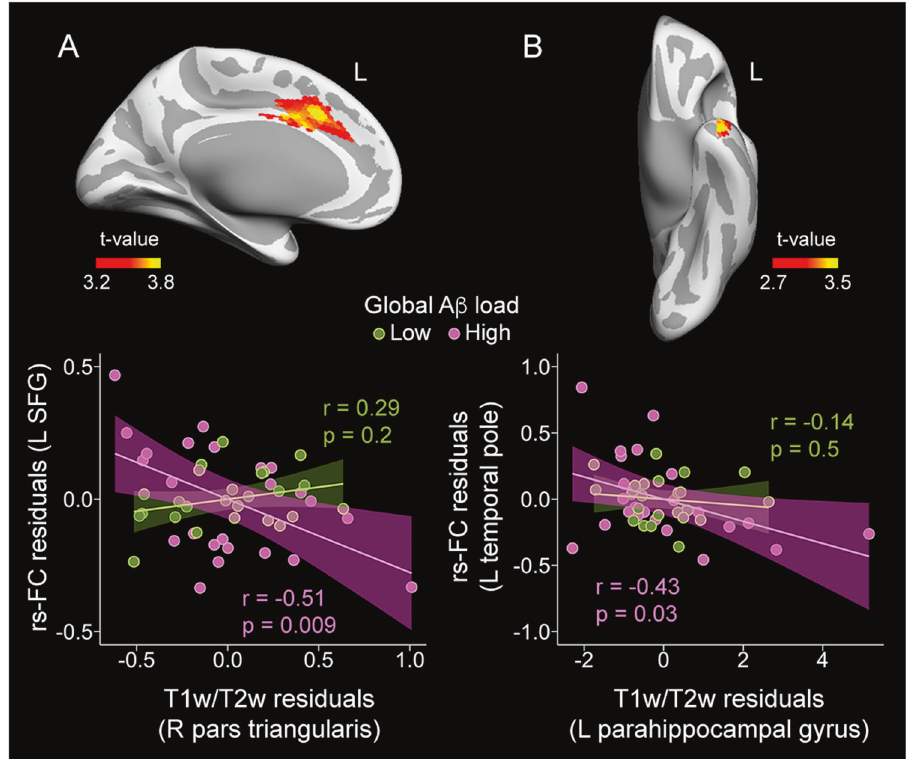
Fig. 2 Partial regression plots showing the moderating effect of A β -related intracortical myelin changes on rs-FC networks. A Pattern of rs-FC using the right pars triangularis as FC seed (upper panel). Participants showing values 1 SD above the mean of global A β load (pink) revealed signi fi cant negative associations between T1w/T2w ratio in the right pars triangularis and rs-FC in the left superior frontal gyrus (SFG). B Abnormal pattern of rs-FC using the left parahippocampal gyrus as FC seed (upper panel). Participants showing values 1 SD above the mean of global A β load (pink) revealed signi fi cant negative associations between T1w/T2w ratio in the left parahippocampal gyrus and rs-FC in the left temporal pole. Figure axes show the residuals from the T1w/T2w ratio and the rs-FC.